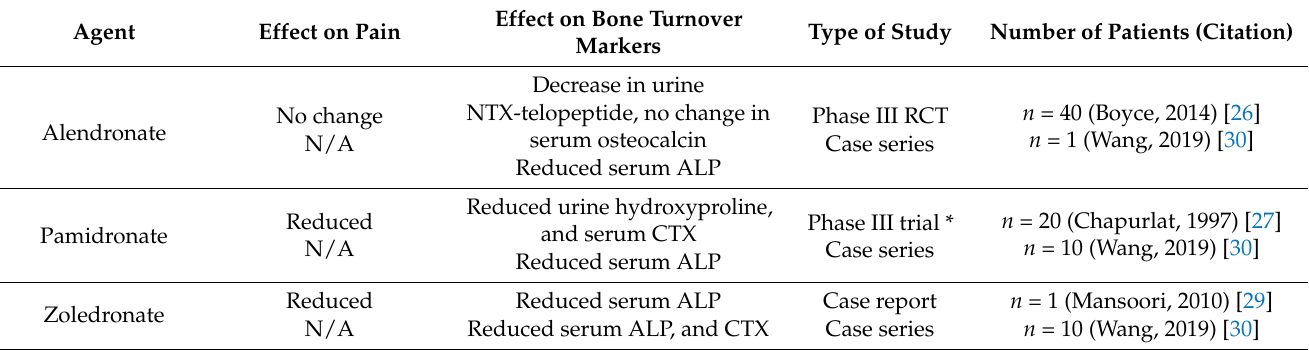
Table 1. The effect of disease-modifying agents on bone pain, BTM listed by type of study. Effect on Bone Turnover Agent Effect on Pain Type of Study Number of Patients Markers